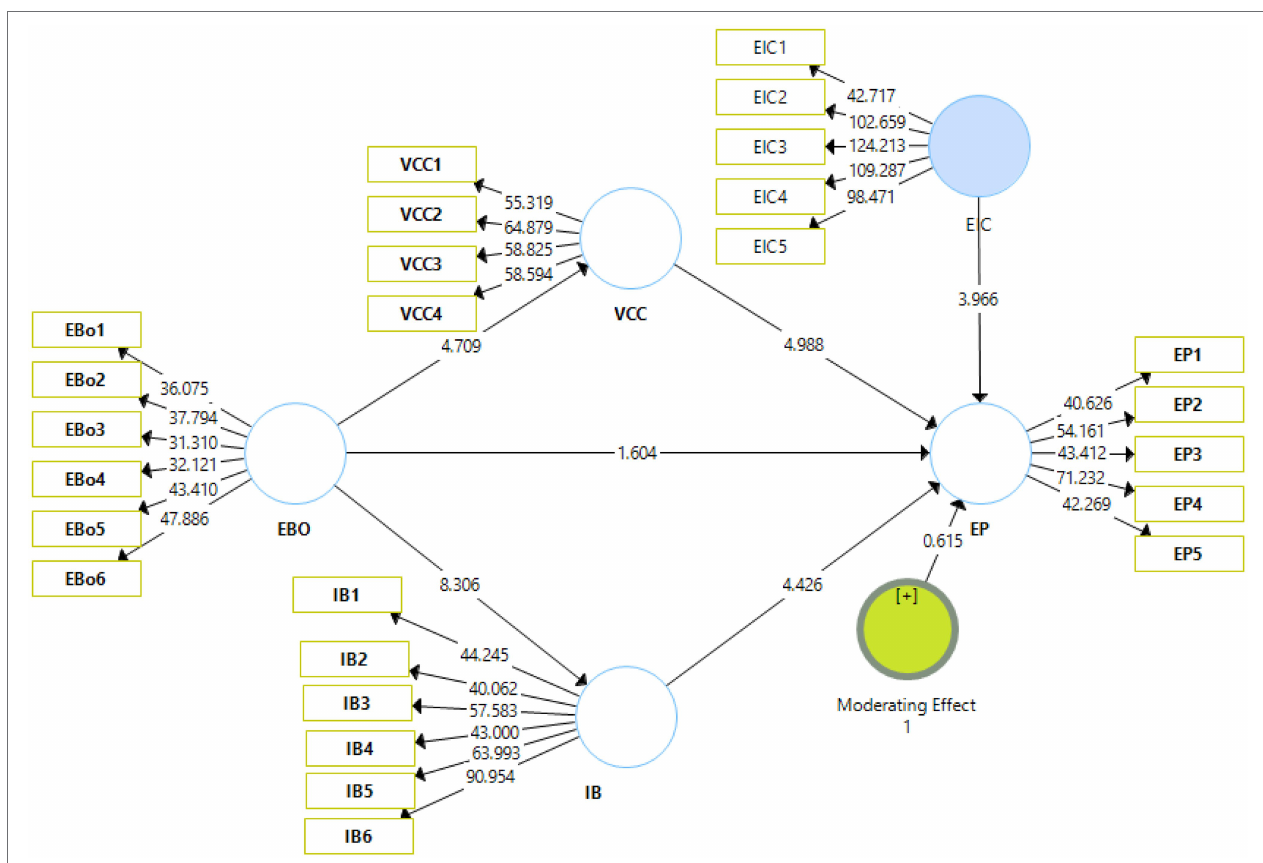
FIGURE 5 | Structural model bootstrapping (Moderation). EBO, enterprise brand orientation; VCC, customer value co-creation; IB, internal branding; EP, brand